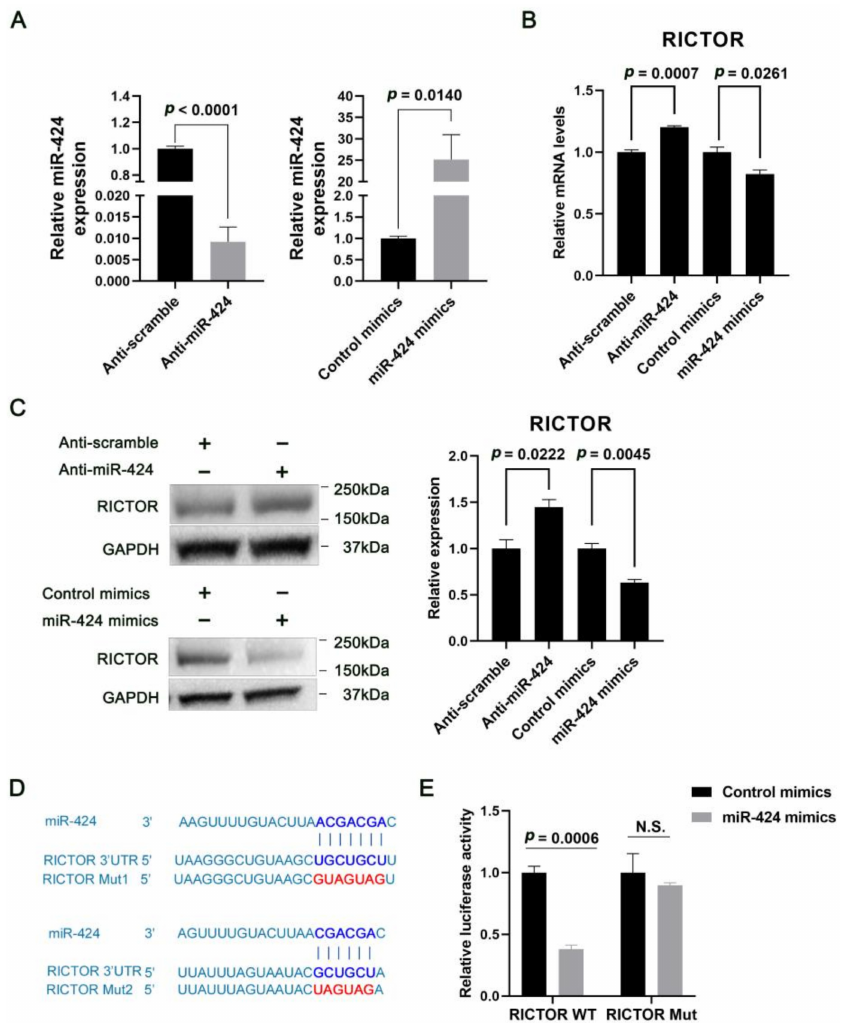
Figure 2. miR-424 directly targets RICTOR in human neural cells. ( A – C ) The effects of miR-424 on RICTOR mRNA and protein expression in human SH-SY5Y cells. qRT-PCR and Western blot- ting were used to assess the mRNA and protein expressions 72 h after transfection with control mimics, miR-424 mimics, anti-scramble, or anti-miR-424. Relative mRNA and protein levels were normalized to U6/ACTB (miR-424/RICTOR) and GAPDH, respectively. Representative blots are shown. ( D ) Predicted miR-424 binding sites within the 3 (cid:48) UTR of RICTOR. The mutated sequences in the miR-424 binding sites are highlighted in red. ( E ) Relative luciferase activities of the wild-type (RICTOR WT) or double mutant (RICTOR Mut) pGL3 promoter vectors co-transfected with either miR-424 mimics or control mimics into SH-SY5Y cells. Error bar = SEM (standard error of the mean); N.S., not significant; n = 3. WT, wild type; Mut,